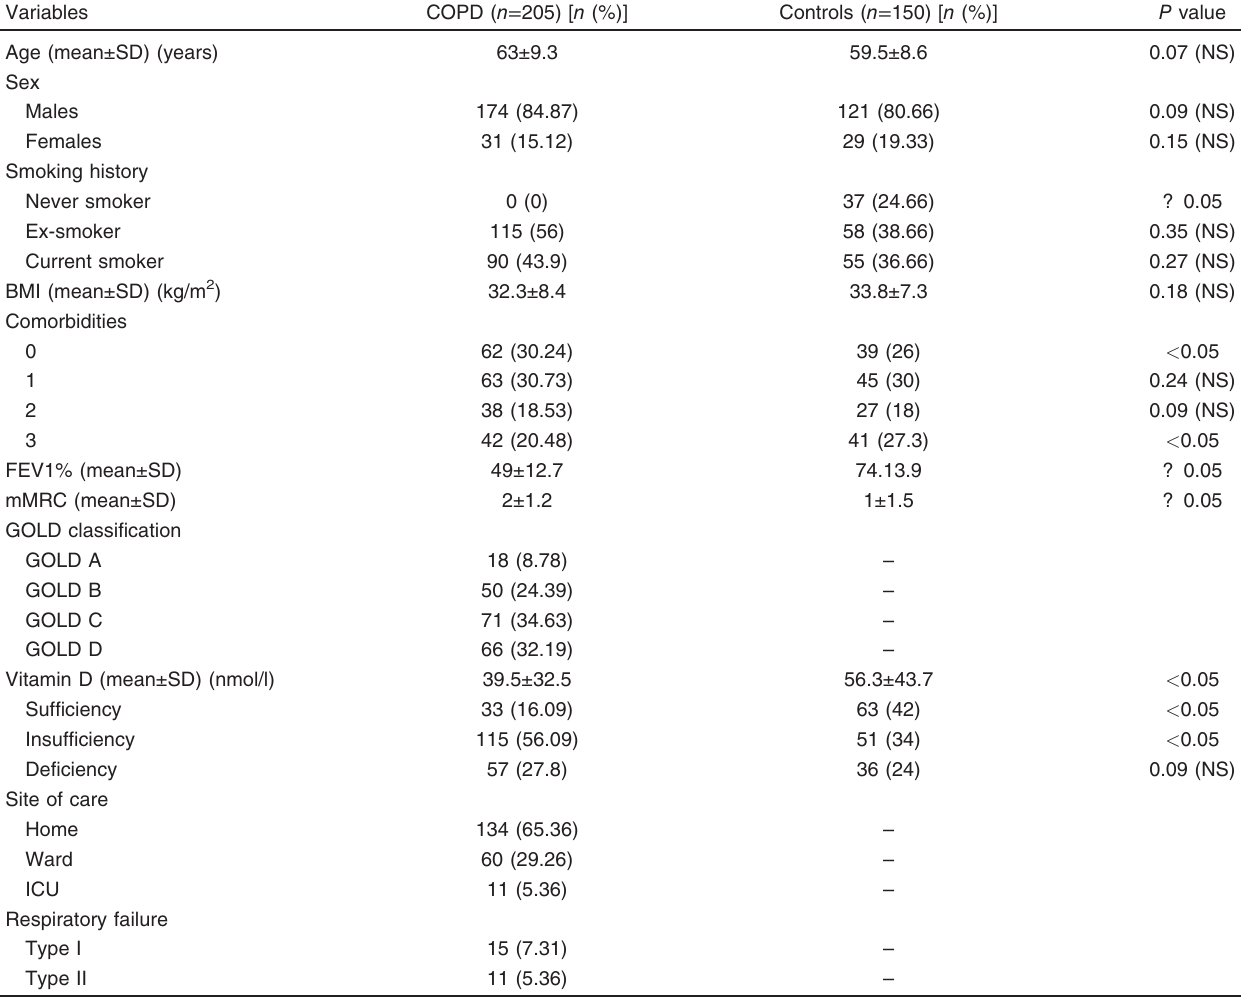
Table 1 Baseline characteristics of patients with exacerbation of chronic obstructive pulmonary disease and control group